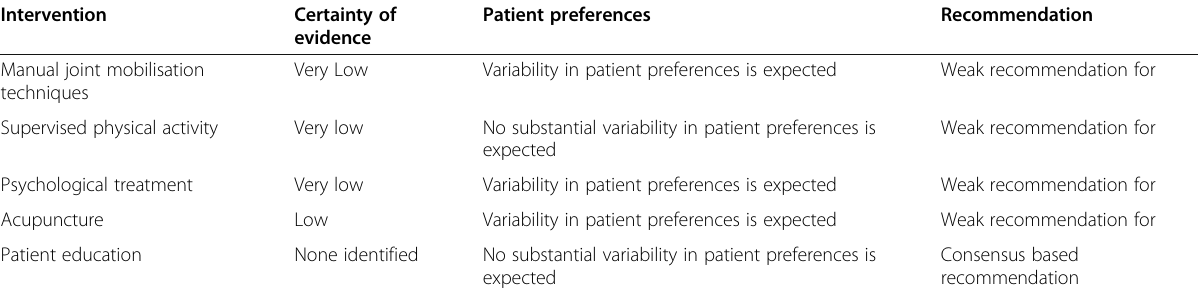
Table 2 Overview of the recommendations for the use of non-pharmacological treatments for patients with tension-type headache